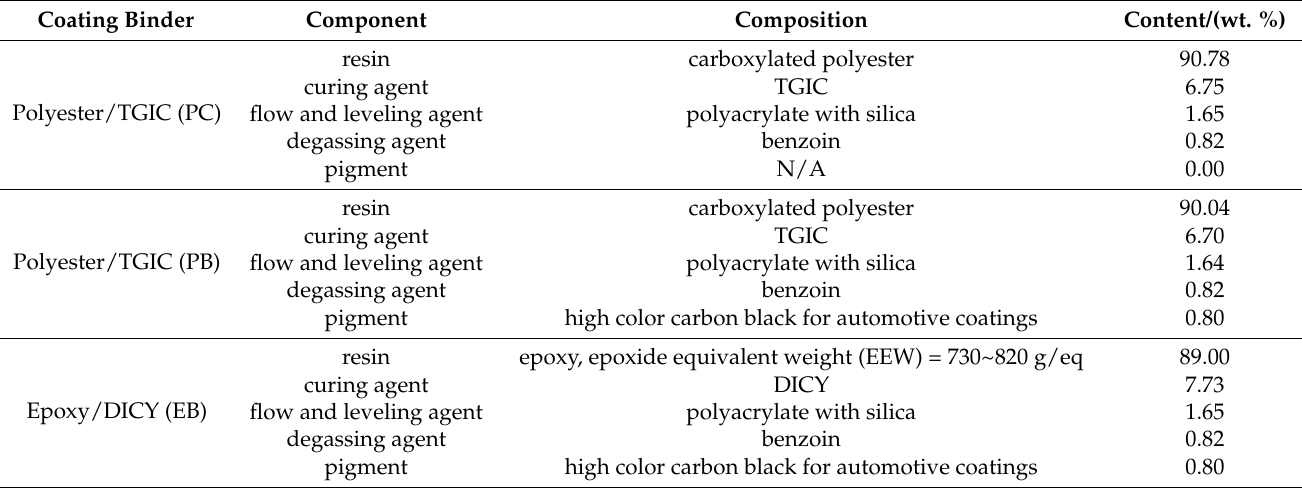
Table 2. Binder formulae of polyester/TGIC powder clearcoat (PC), black polyester/TGIC (PB), and black epoxy/DICY (EB) powder coatings.